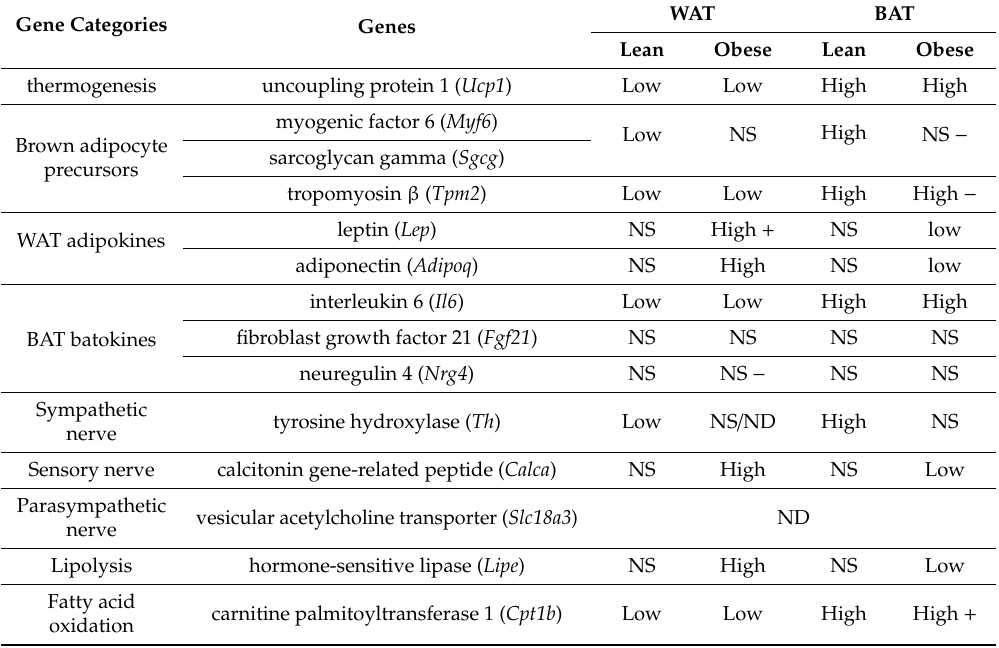
Table 1. Genes compared between white adipose tissue (WAT) and brown adipose tissue (BAT) of lean and obese male mice using RNA sequencing